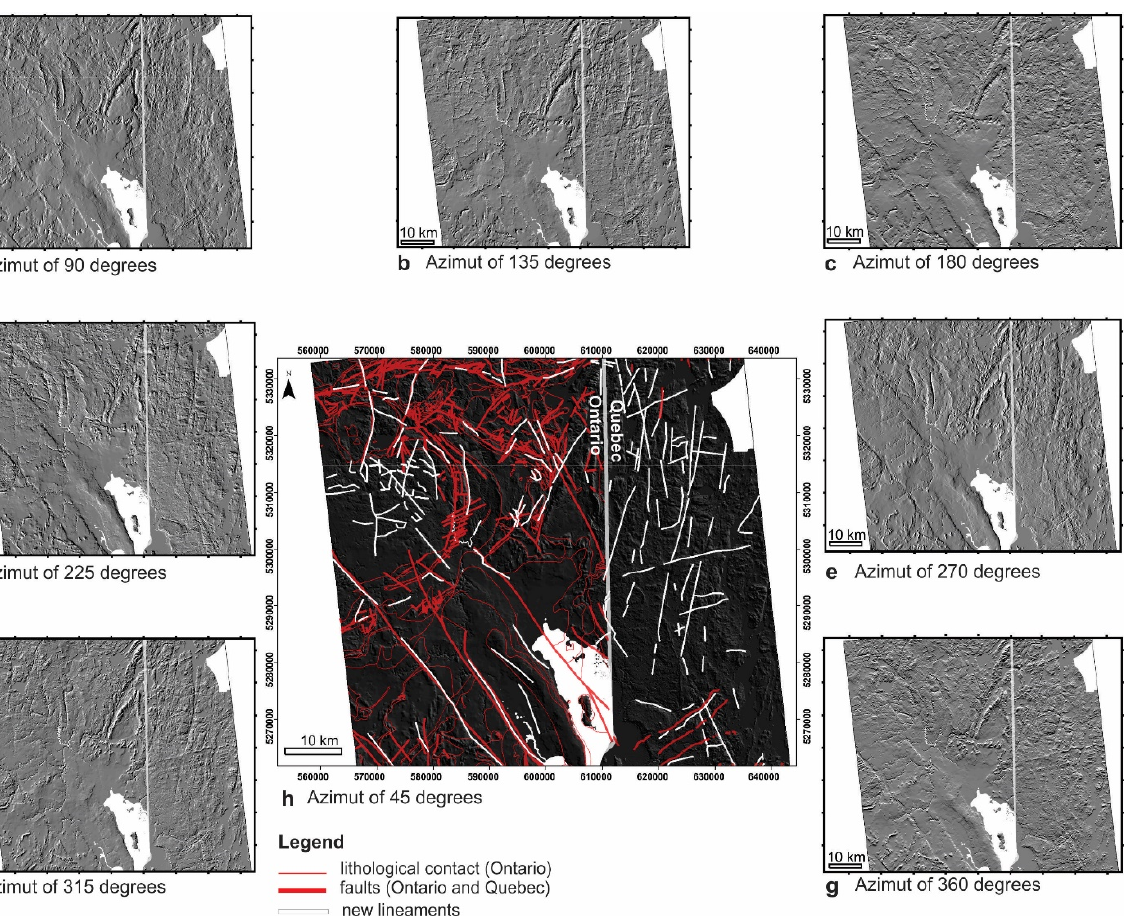
Figure 7. Morpholineaments mapped in Subset 5; the hillshades from panels ( a – g ) were calculated with a sun altitude of 10 degrees across the different azimuths; ( h ) compendium of all mapped lineaments in comparison with previously mapped faults and lithological contacts.